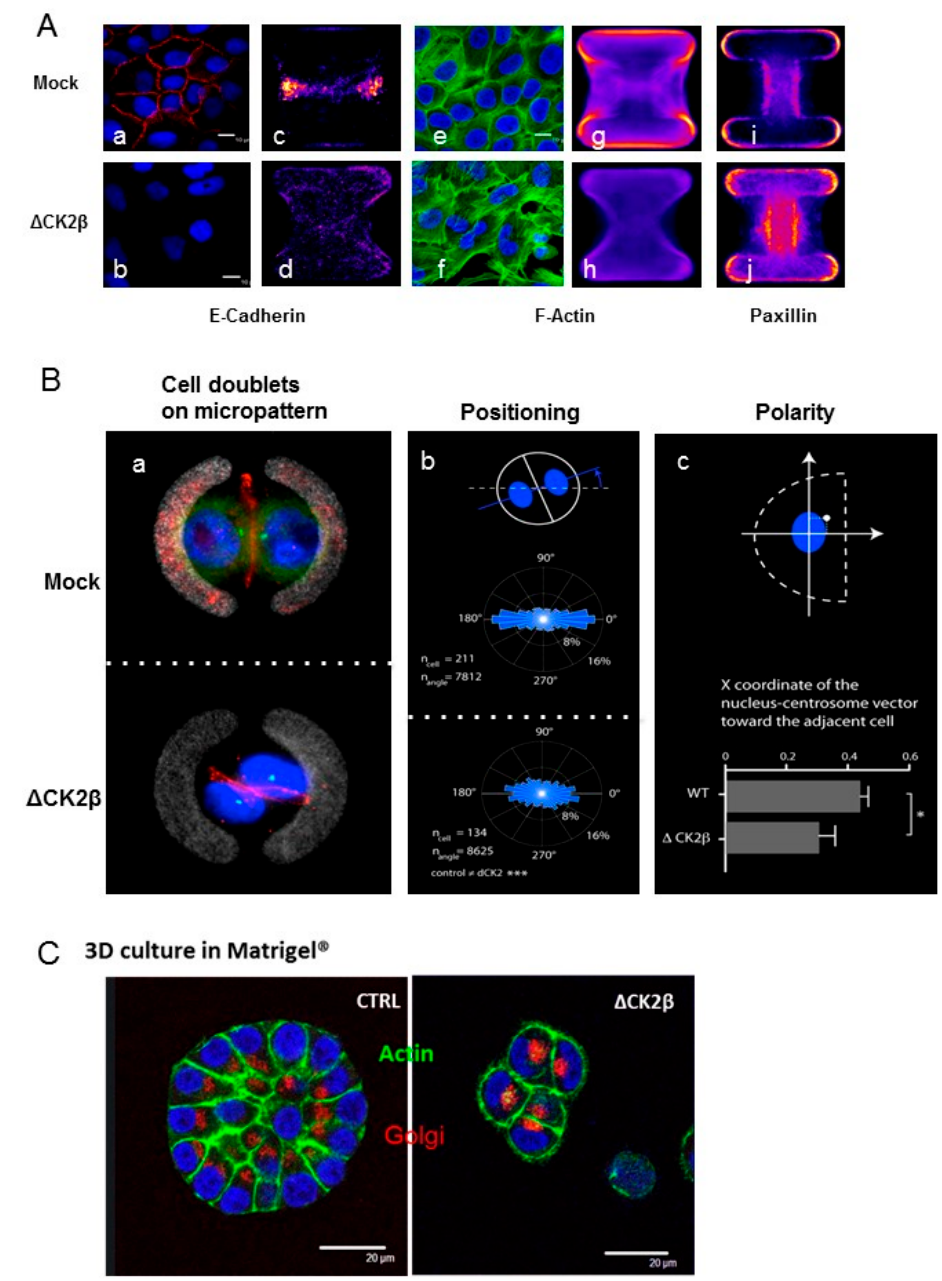
Figure 3. Δ CK2 β - and Mock-MCF10A cell positioning and polarity. ( A ) Mock and Δ CK2 β - MCF10A cells cultured as monolayer (a,b,e,f) or as doublets on H-shaped micropatterns (c,d,g–j) were stained for DNA (blue, a,b,e,f), E-cadherin (red, a–d), F-actin (green, e–h) or paxillin (far red, i,j). Average staining over 20 images on pattern is shown (c,d,g–j). Scale bar, 10 μ m; ( B ) (a) Representative image of doublet cells stained for α -catenin (red), centrosome (green), and DNA (blue) on curved H-shaped micropattern; (b) Time-lapse acquisition of control- and Δ CK2 β -MCF10A cell doublets on micropattern was performed. Automated movie analysis of Hoechst-stained cells provided the angular distribution of the nucleus–nucleus axis orientation that is represented by graph; (c) The X coordinate of the normalized nucleus-centrosome vector toward the cell-cell junction was calculated. Horizontal bar graph shows quantification of polarity index as previously described [47]; ( C ) Confocal images of 3D culture in Matrigel ® for nine days, of Mock- and Δ CK2 β -MCF10A cells stained for DNA in blue, F-actin in green, and Golgi apparatus in red. Scale bar, 20 μ m.